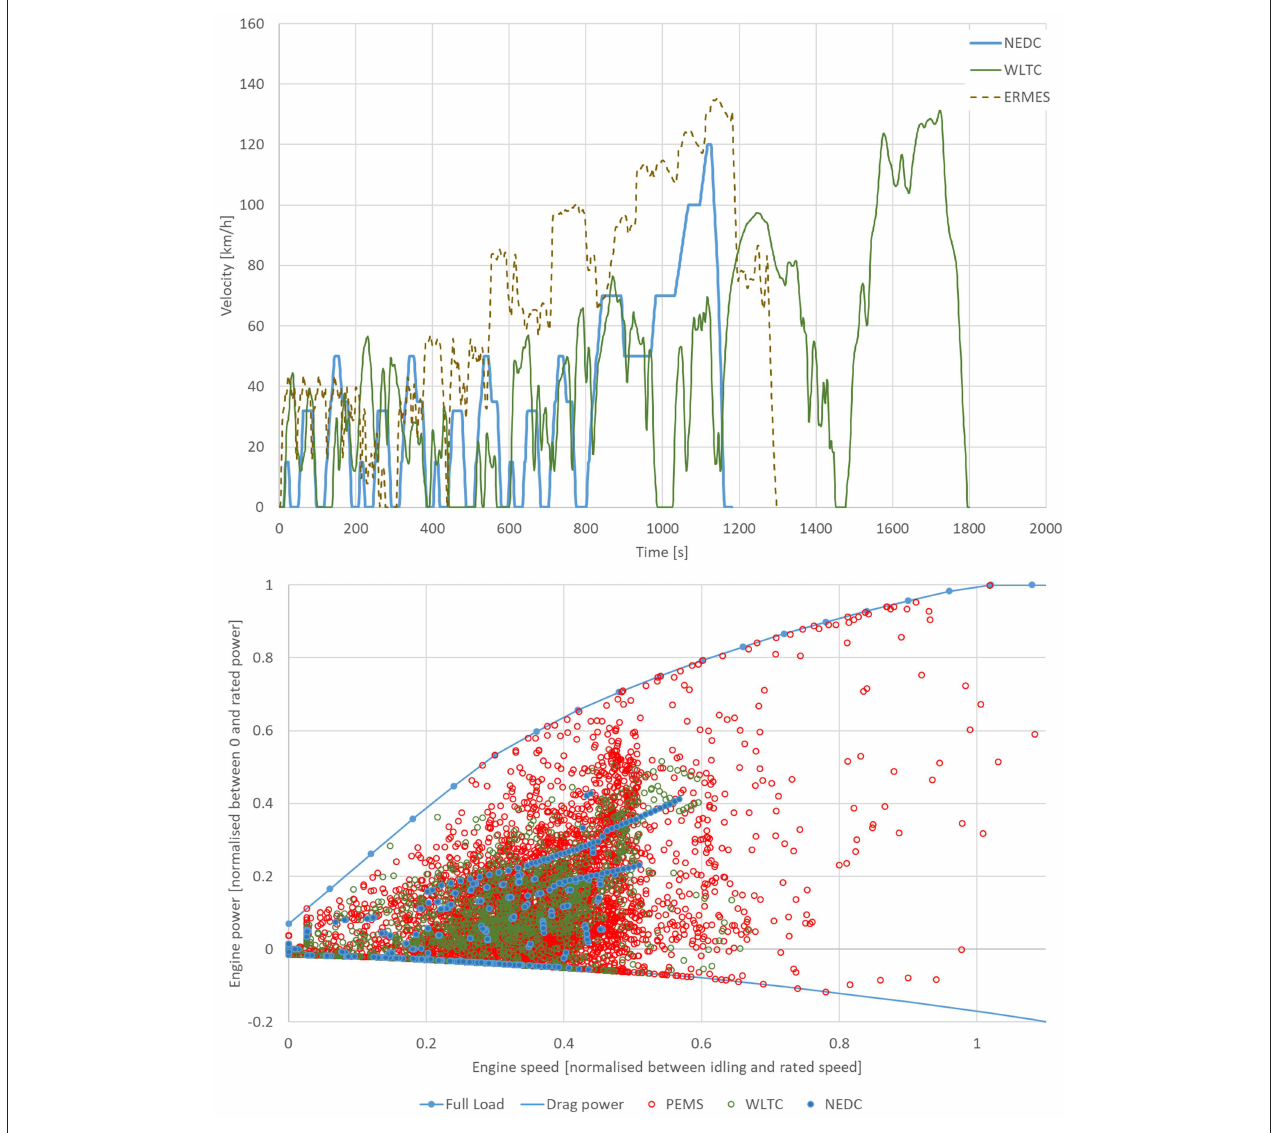
FIGURE 2 | Comparison of NEDC, WLTC and real world cycle (Kufferath et al., 2019).